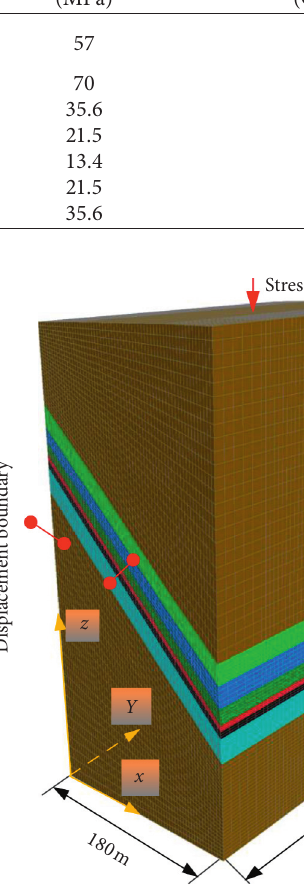
Figure 5: Numerical model.